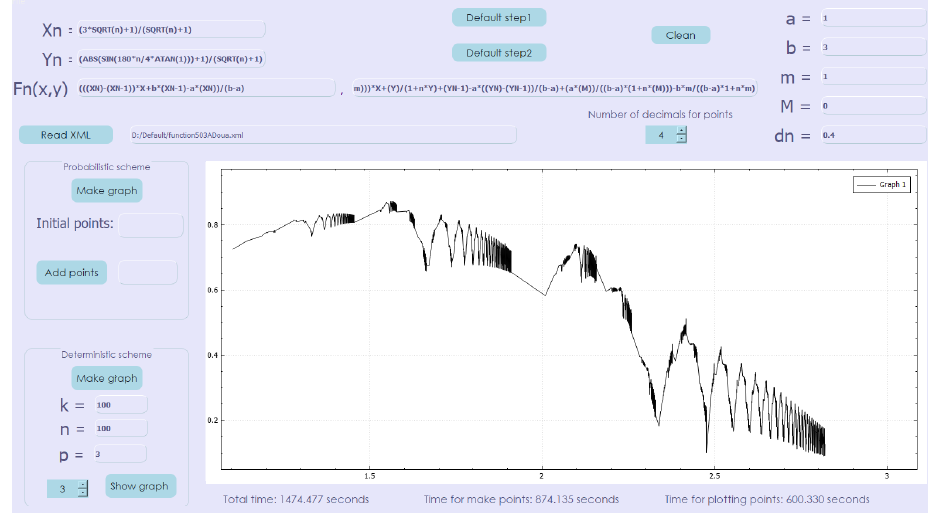
Figure 3. Non-affine deterministic interpolation scheme (approximation with 100,000,000 points).